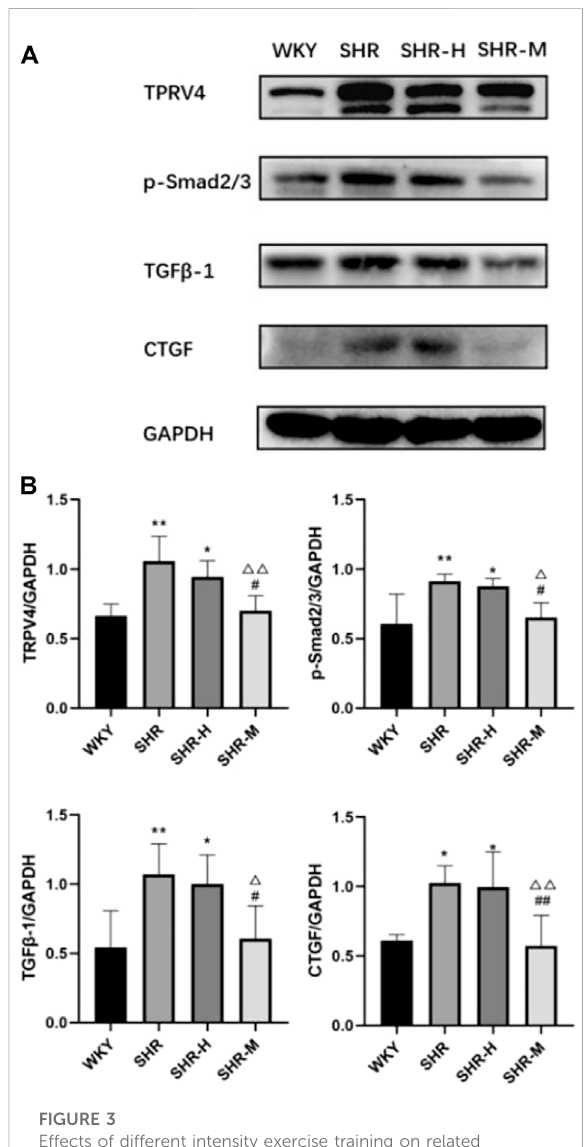
Effects of different intensity exercise training on related fi brotic molecules. (A) Western blotting result and responding quanti fi cation of protein products of transient receptor potential vanilloid 4 (TRPV4), transforming growth factor-beta (TGF β - 1), anti-Smad2 (phosphoT8) + Smad3 (phosphoT8) (p-Smad2/3), and connective tissue growth factor (CTGF) extracted from the renal tissue. (B) Bars represent the corresponding protein quanti fi cation of TRPV4, TGF β -1, p-Smad2/3, and CTGF on the basis of GAPDH. Values are mean ± S.D. ( n = 5 in each group). * p < 0.05 and ** p < 0.01 versus the WKY group. △ p < 0.05 and △△ p